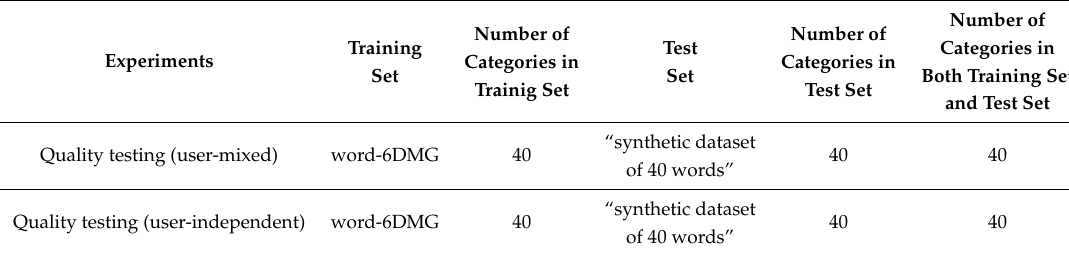
Table 3. Experiment setup for quality testing.